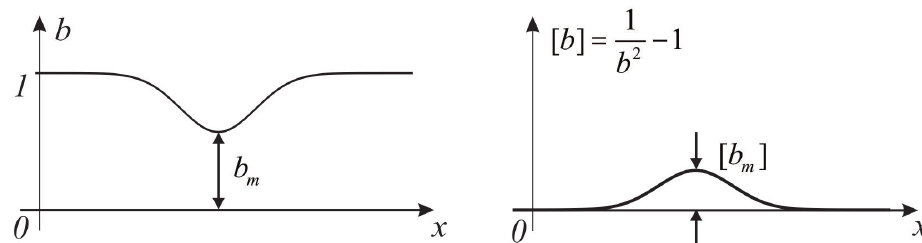
Figure 3. ( Left ) Illustration of channel width b ( x ) , and ( right ) its transformation [ b ] ≡ 1/ b 2 − 1. Consider a subcritical flow from left to right passing over a flat channel with a varying width b ( x ) , that tends to unity near the left and right boundaries. On the upstream part, water height is set to be h = 1, and the channel width is b ( x ) = 1 (or [ b ( x )] = 0). On the curve k ( h ) , this upstream flow is represented as a point ( h 1 = 1, 0 ) , see Figure 4 (Left). As the channel width decreases from the normal width b = 1 to b m , the flow accelerates.